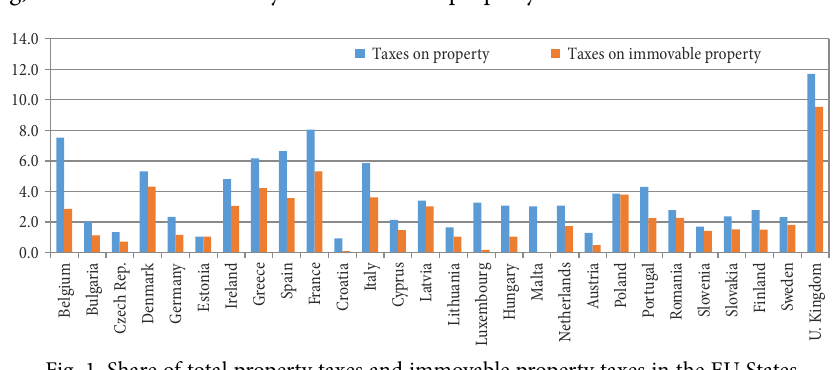
in 2012 in the total tax revenues (%)